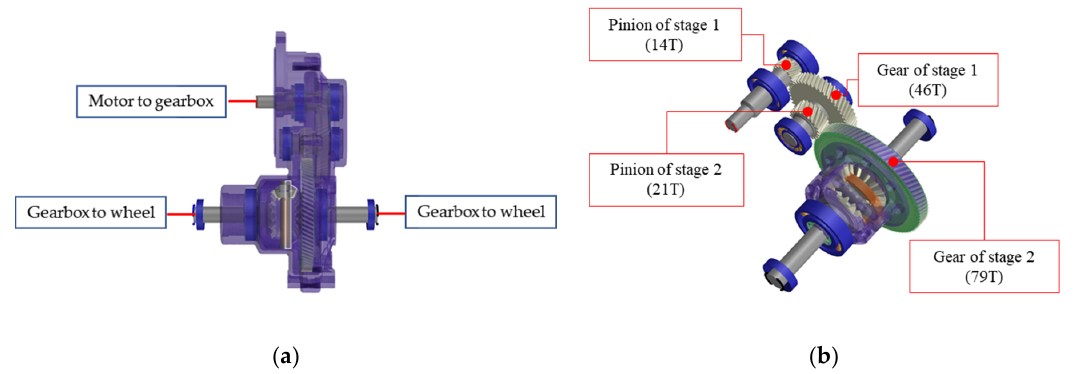
Figure 2. Gear train of reduction gearbox. ( a ): Power flow; ( b ): Number of gear teeth.